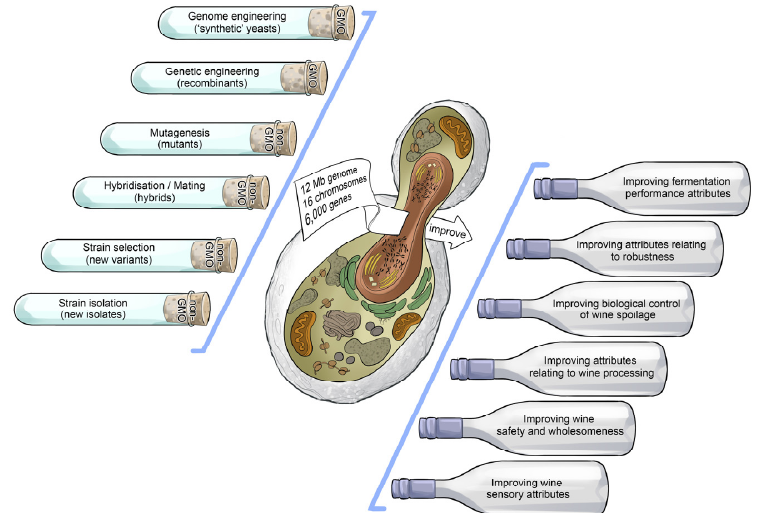
Figure 14. Different strain development techniques used to optimise certain winemaking properties of selected wine yeasts. These techniques include genetic modification (GM) and non ‐ GM techniques. They are applied to study and improve yeast attributes relating to fermentation performance, robustness, spoilage-control, processing efficiency, product wholesomeness and sensory quality. It continues to boggle the minds of many researchers why GM medicine has been accepted widely, whereas GM food products (including wine) have not, despite the numerous studies demonstrating that such products are no more unsafe to eat or drink than any other food product. This scientific and cultural quagmire becomes even more intriguing when one considers, for example, the more than 1000 transposons that ‘jump and bounce’ all over the grapevine genome—genetically modifying the Vitis vinifera genome in every vineyard across the commercial wine-producing world without any intervention by